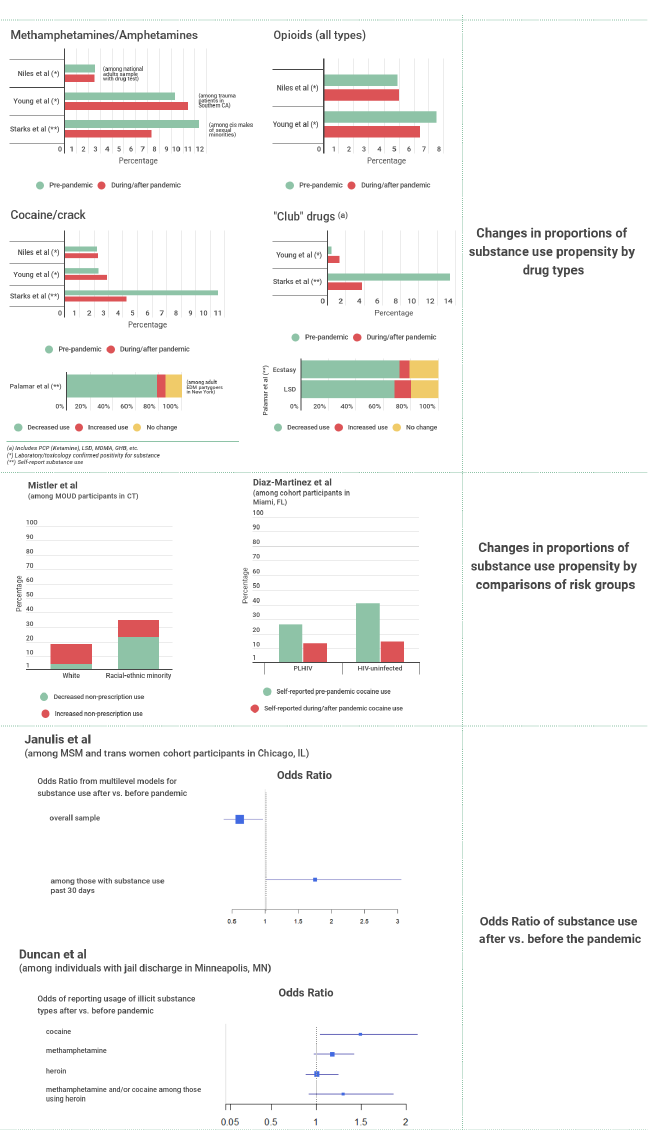
Figure 3. Summary evidence for changes in illicit substance use frequency associated with the pandemic. PCP = Phencyclidine. LSD = Lysergic Acid Diethylamide. MDMA = Methylenedioxy-Methamphetamine. GHB = Gamma Hydroxybutyrate. PLHIV = People Living with HIV. MSM = Men Who Have Sex with Men. CT = Connecticut. MN = Minnesota. IL = Illinois